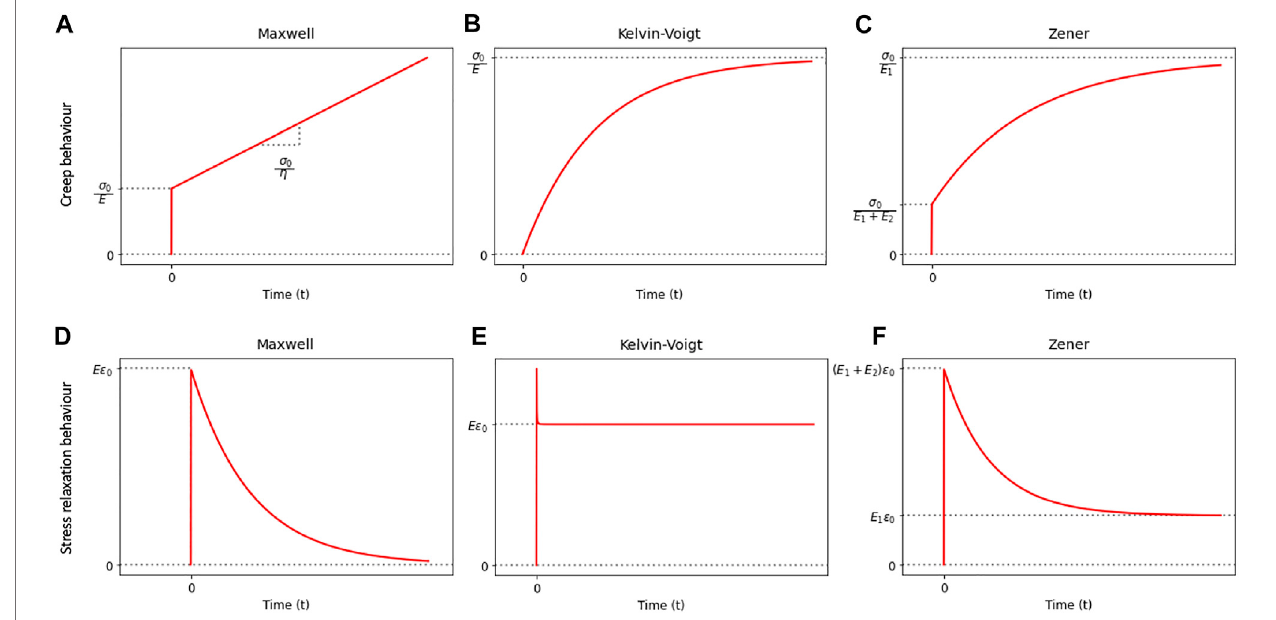
FIGURE 3 | Illustration of the creep and stress relaxation behaviors of the classical rheological